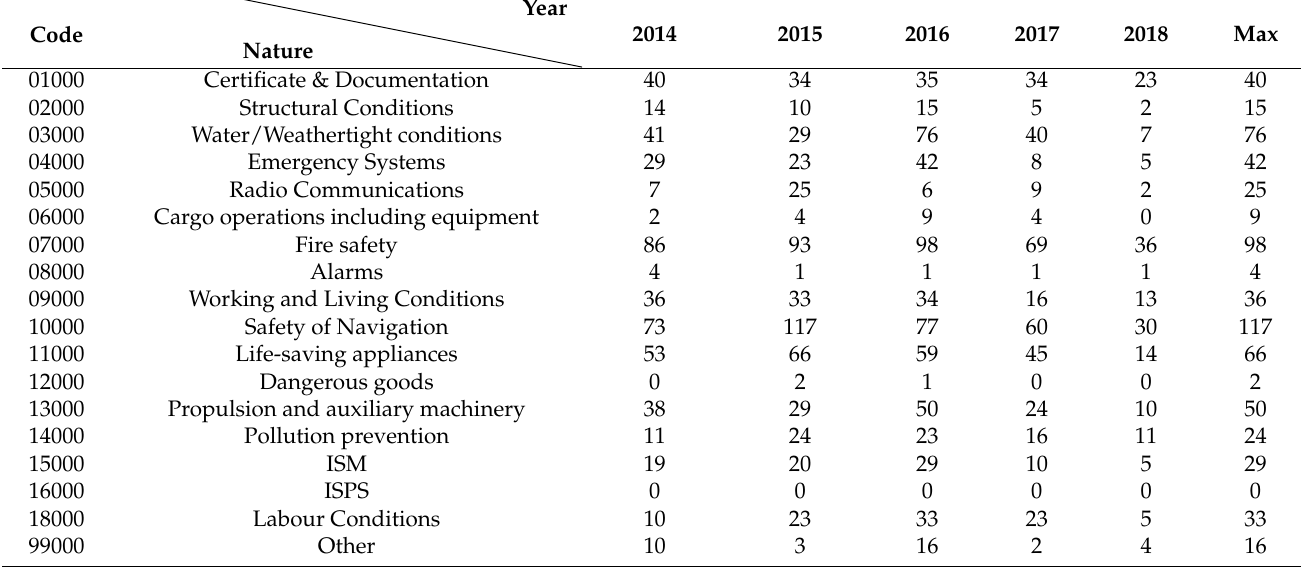
Table A7. Statistics on the deficiencies registered by Taiwanese ships in the Tokyo MoU from 2014 to 2018. Code